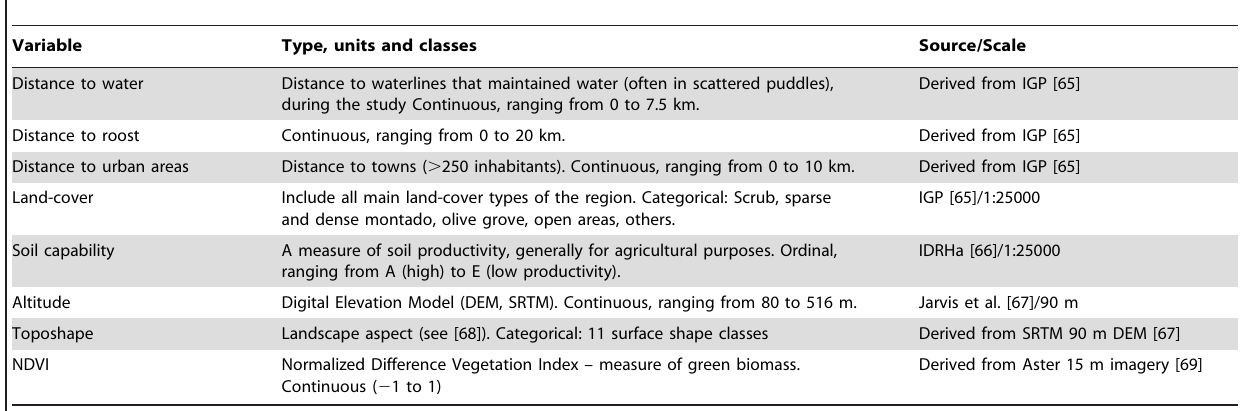
Table 2. Environmental variables used in modelling of the foraging habitat suitability of both bat